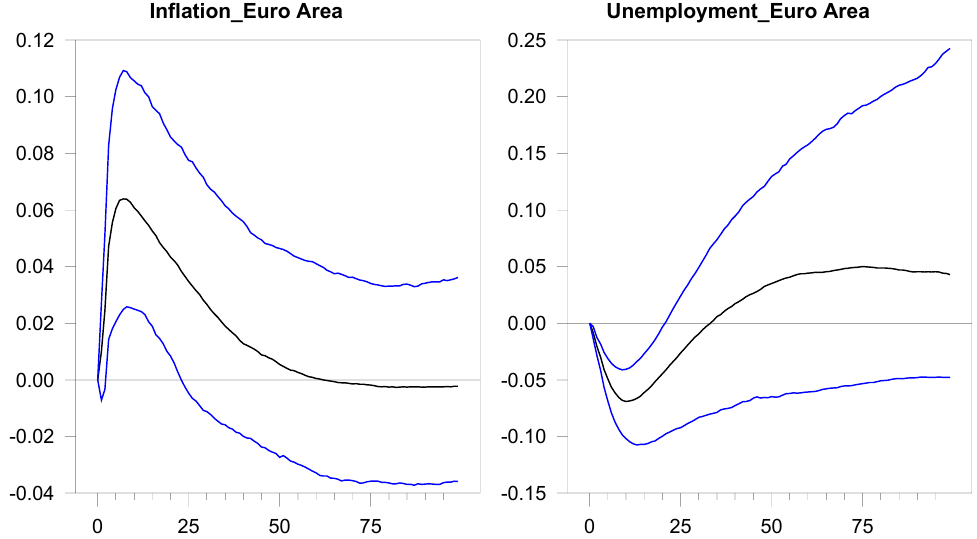
Figure 2. Responses of Euro Area inflation and unemployment to a contractionary monetary policy shock. Monetary policy shock identified as exogenous innovation to European Overnight Average Interest Rate (EONIA). Error bands set at the 10th and the 90th percentiles. VAR model including Brent price of oil, inflation, unemployment and EONIA.